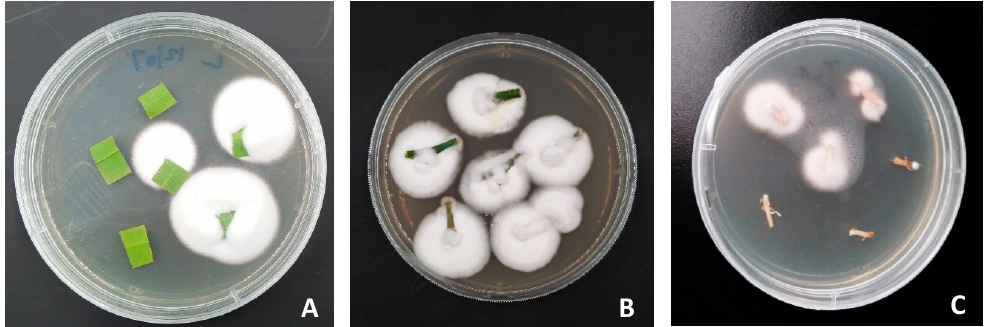
Figure 2. Endophytic entomopathogenic fungi ( Bassiana bassiana BB Fafu-13) re-isolation from ( A ) leaf, ( B ) stem, and ( C ) root tissues of Citrus limon plant following foliar treatment with fungal conidia suspension. Table 1. Colonization frequency of endophytic entomopathogenic fungi in Citrus limon plants segments (leaf, stem and root) at di ff erent weeks post inoculation (wpi) following foliar treatment of seedlings with 1 × 10 8 conidia mL − 1 of each of the treated Beauveria bassiana isolates (BB Fafu-13 and BB Fafu-16). Colonization Frequency in Di ff erent Plant Segments Treatments Leaf